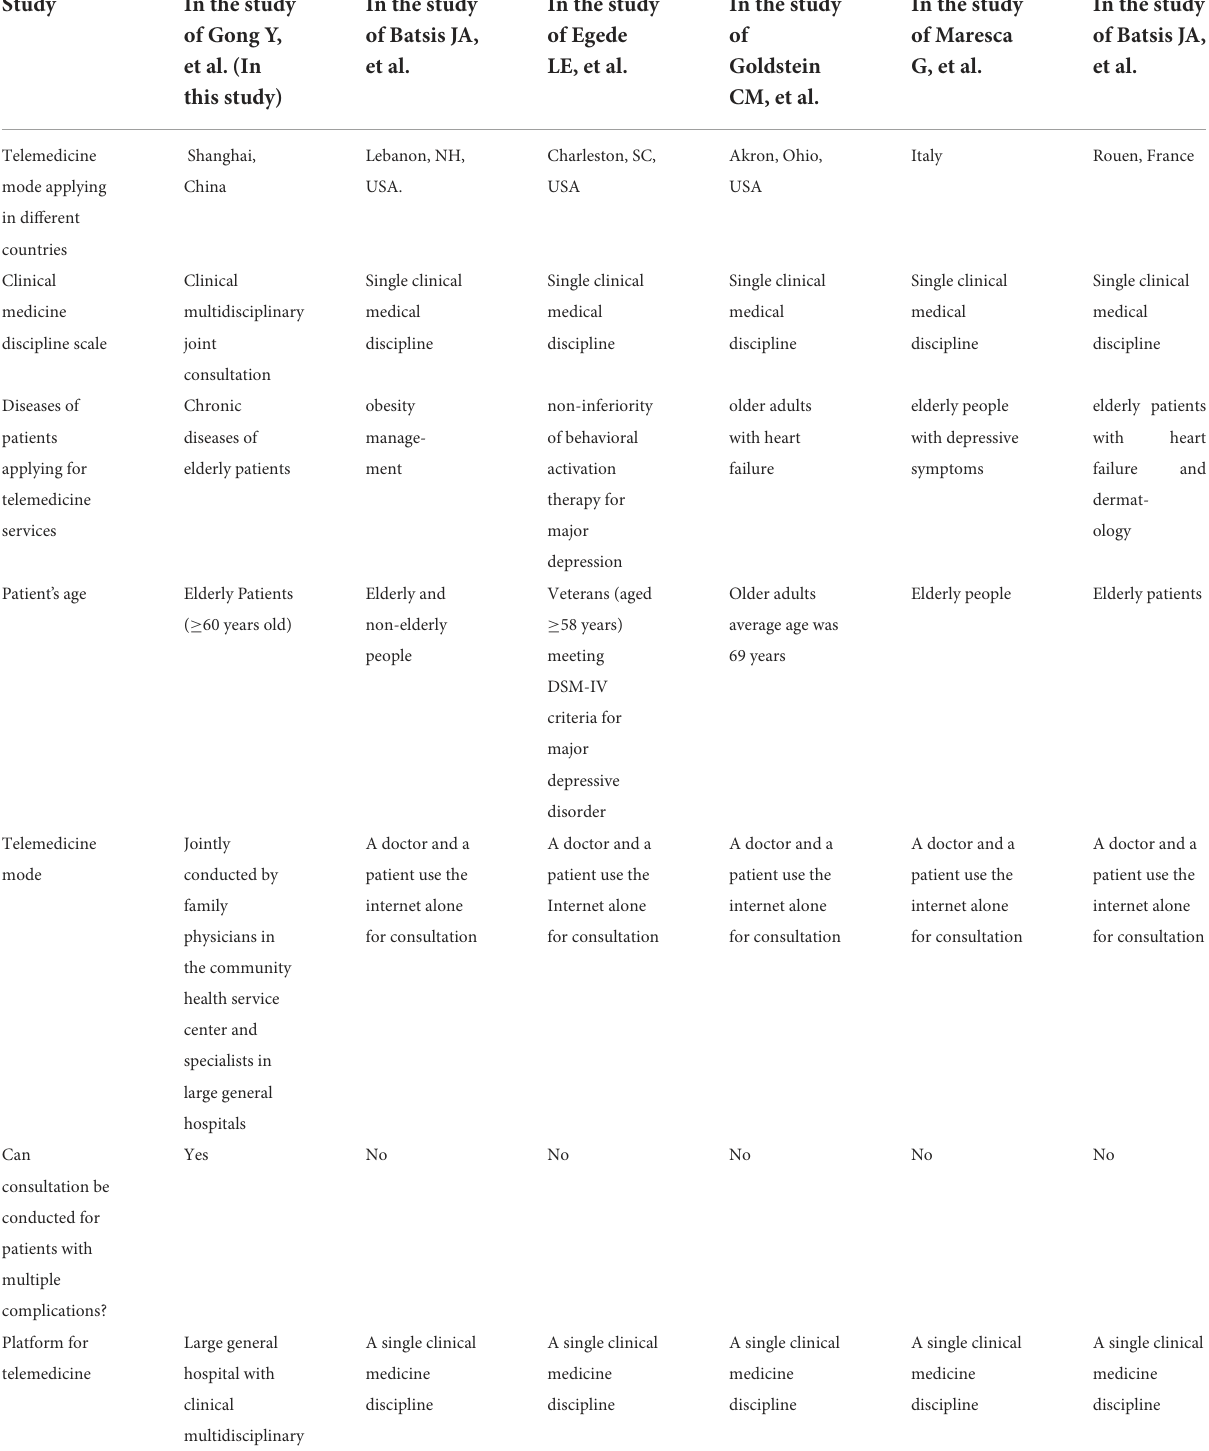
TABLE 2 Comparison of the differences between the new telegeriatrics system in our study and telemedicine systems of the main studies mentioned in the